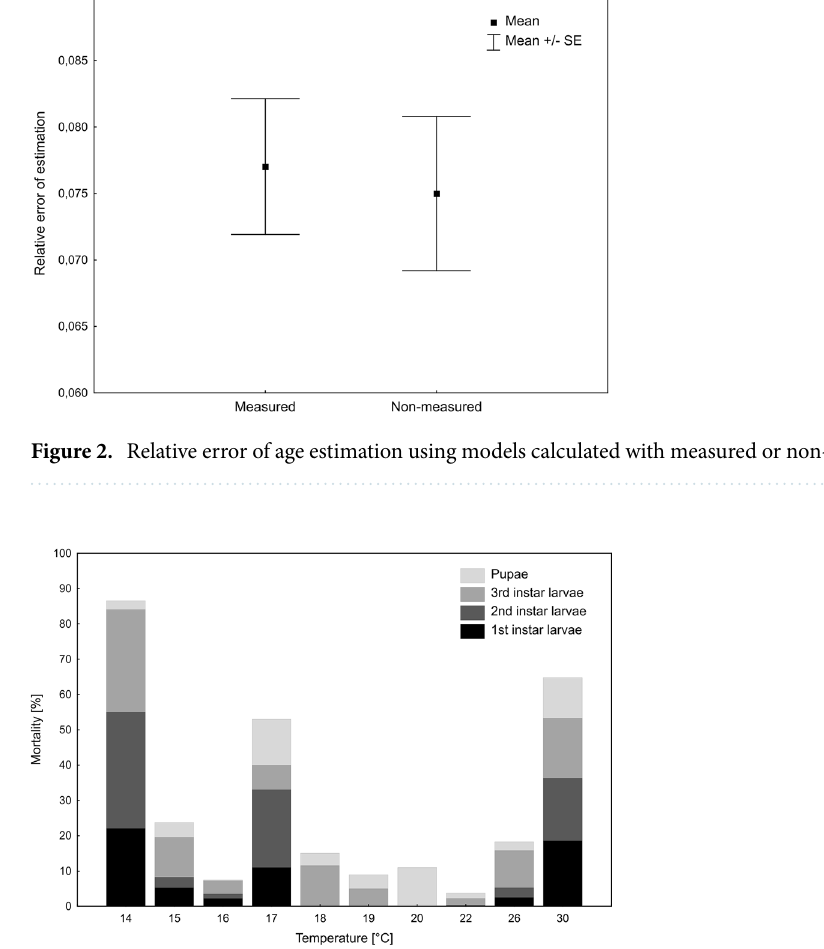
Figure 3. Mortality of N. littoralis at immature developmental stages in different rearing temperatures.